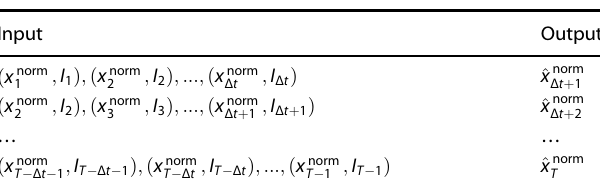
Fig. 4 Comparison of test results on channel yy ( σ yy ) from different models. StressNet combined with Dynamic Fusion Loss Function has the best performance (solid blue line). Table 1. Input and output at the training phase. Table 2. Input and output at the testing